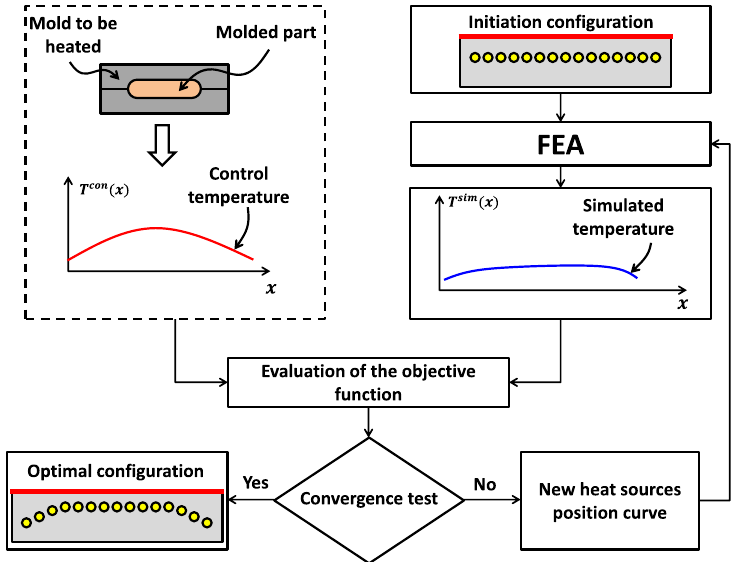
Fig. 5. Schematic representation of the calculation algorithm.